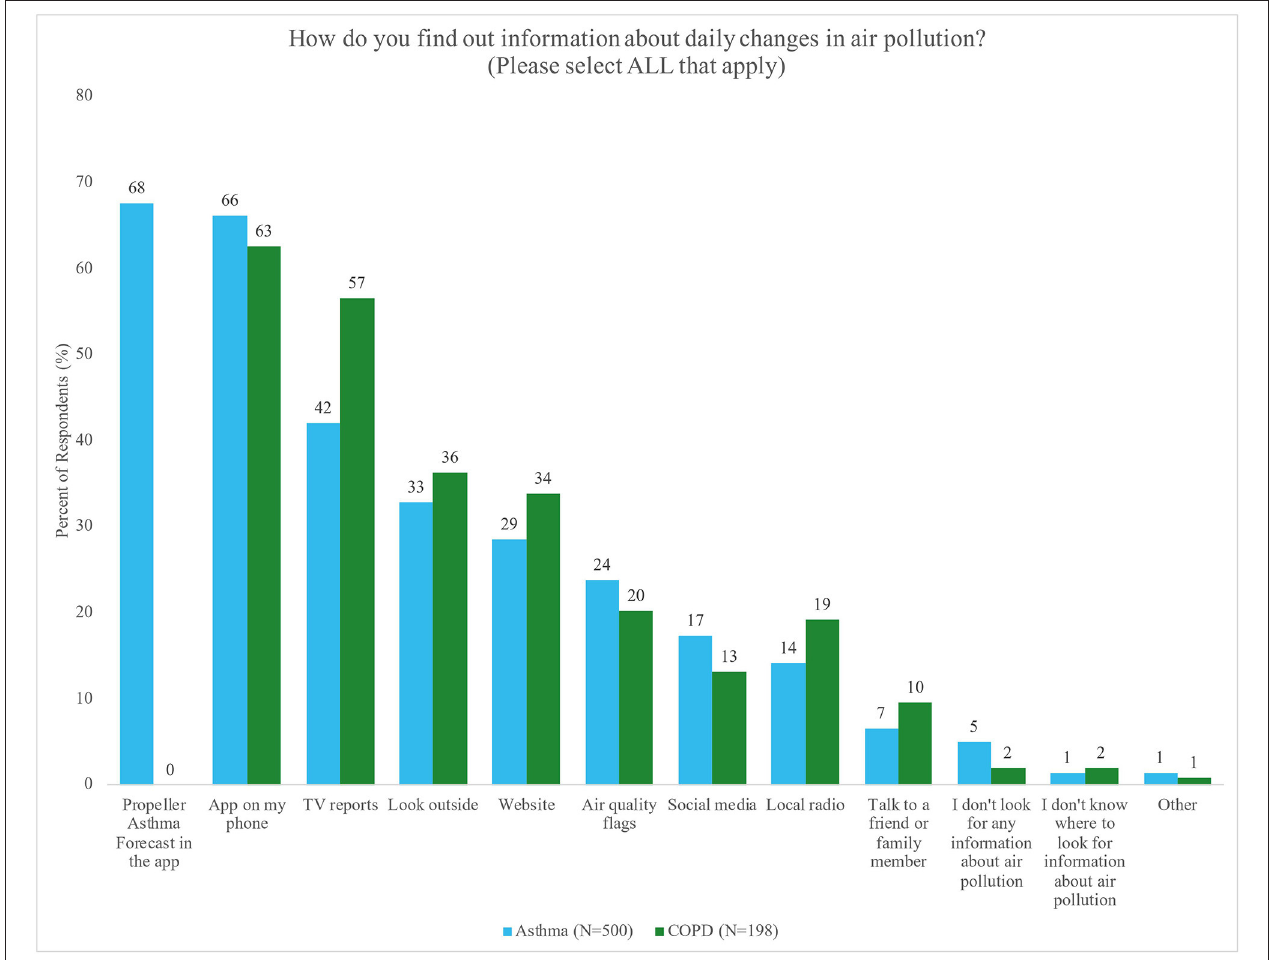
FIGURE 2 | Percent of respondents with asthma (blue) or COPD (green) who reported preferred sources for seeking information about daily changes in air pollution. Participants could select more than one answer.